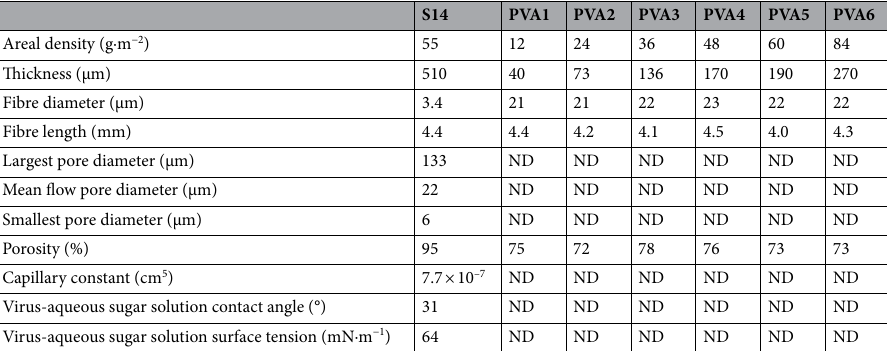
Table 2. Physical characteristics of glass fibre (S14) and PVA matrices. ND not done. Characteristics of S14 are relevant throughout the “Results” section. PVA matrices PVA1-6 are introduced in the final subsection of “Results”, and are relevant only to that subsection. The nomenclature ‘PVA1-6’ refers to six commercially available PVA matrices from within a range produced by Kuraray Co (Japan), as described in the